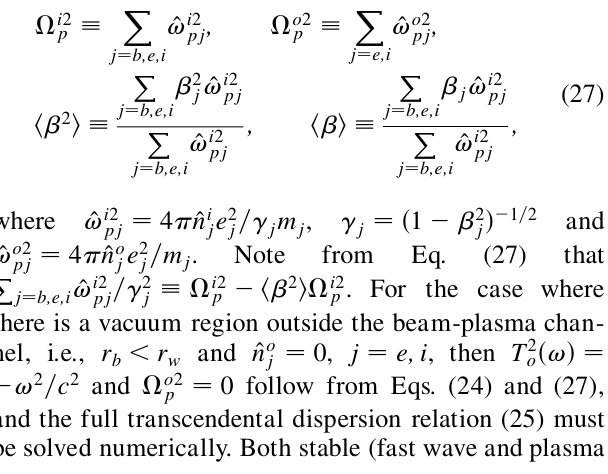
versus mode number n , and (b) eigenfunction (cid:31) ^ E W (cid:7) r (cid:7) 0 : 2 , (cid:30) i = 3 , (cid:15) r =c (cid:7) 3 , and (cid:30) o b w b b p